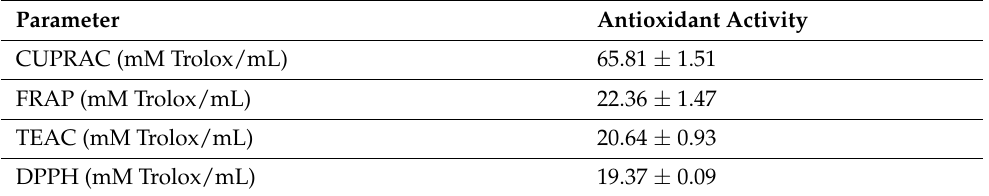
Table 3. Antioxidant activity evaluation by different methods (mean ± SD).